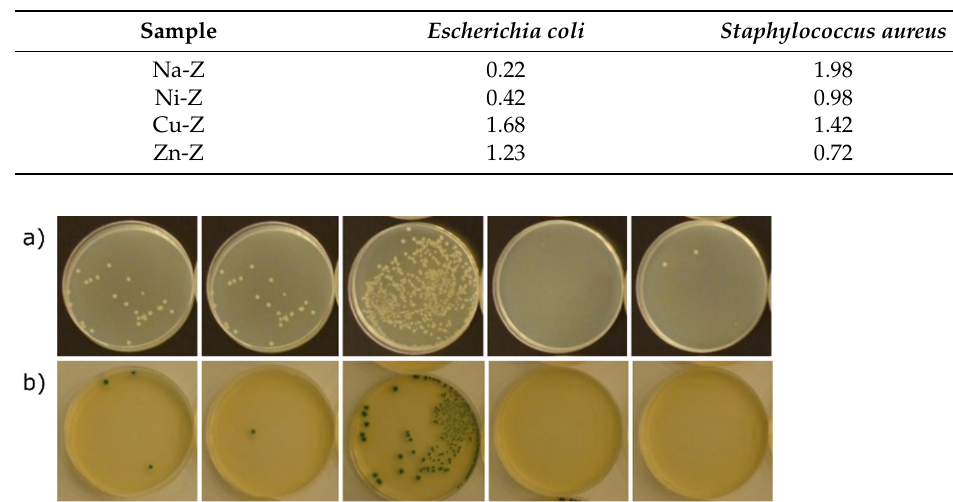
Table 3. Values of the reduction in the number of bacteria as a result of 24 h contact with the tested